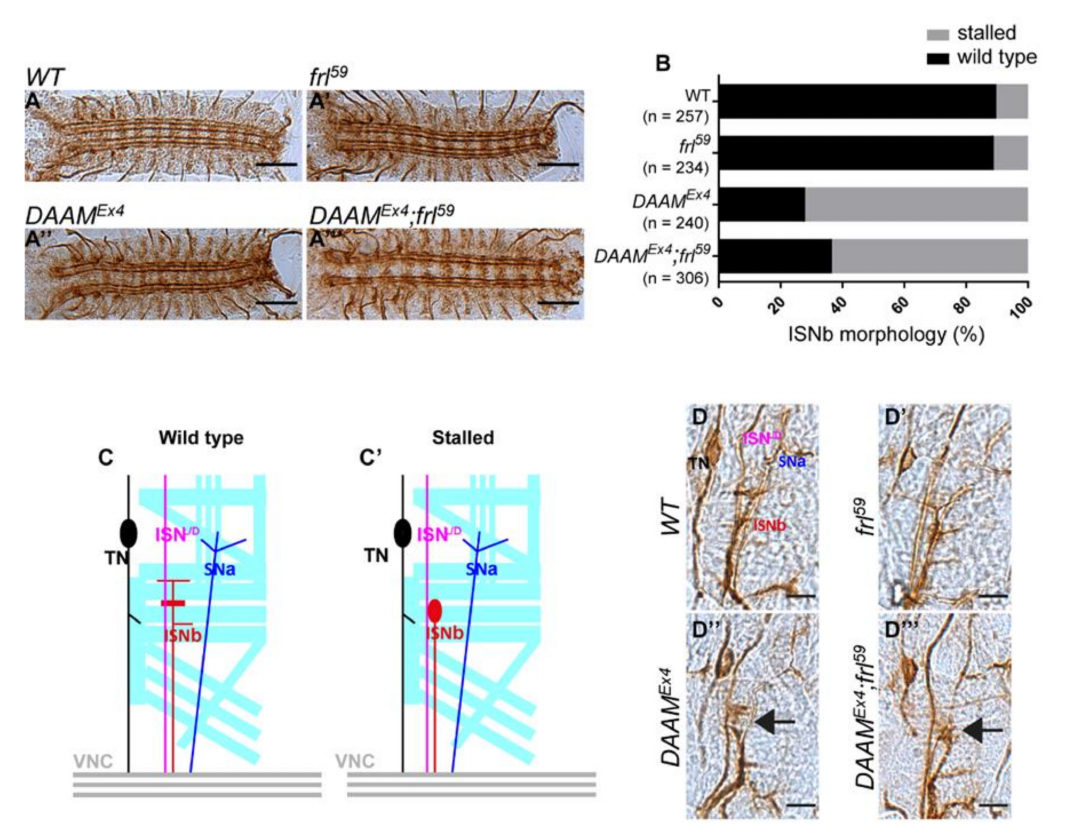
Figure 1. Morphological analysis of the nervous system of DAAM and frl single- and double- mutant embryos. ( A ) Morphology of FasII-positive motoraxons in the ventral nerve cord of wild- type ( A ), frl59 ( A (cid:48) ), DAAM Ex4 ( A (cid:48)(cid:48) ) and DAAM Ex4 /frl 59 ( A (cid:48)(cid:48)(cid:48) ) embryos. Scale bar represents 50 µ m. ( B ) Frequency of ISNb phenotypes in wild-type and mutant embryos. ( C – C (cid:48) ) Schematic representa- tion of wild-type and mutant (stalled) motoraxons (TN—transverse nerve, ISNb—intersegmental nerve b, ISNa—intersegmental nerve a, SNa—segmental nerve a). ( D ) Morphology of the FasII- positive motoraxons in the ISNb of wild-type ( D ), frl 59 ( D (cid:48) ), DAAM Ex4 ( D (cid:48)(cid:48) ) and DAAM Ex4 ; frl 59 ( D (cid:48)(cid:48)(cid:48) ) embryos. Arrows in ( D (cid:48)(cid:48) ) and ( D (cid:48)(cid:48)(cid:48) ) point to the stalled ISNb. Scale bar represents 10 µ m.